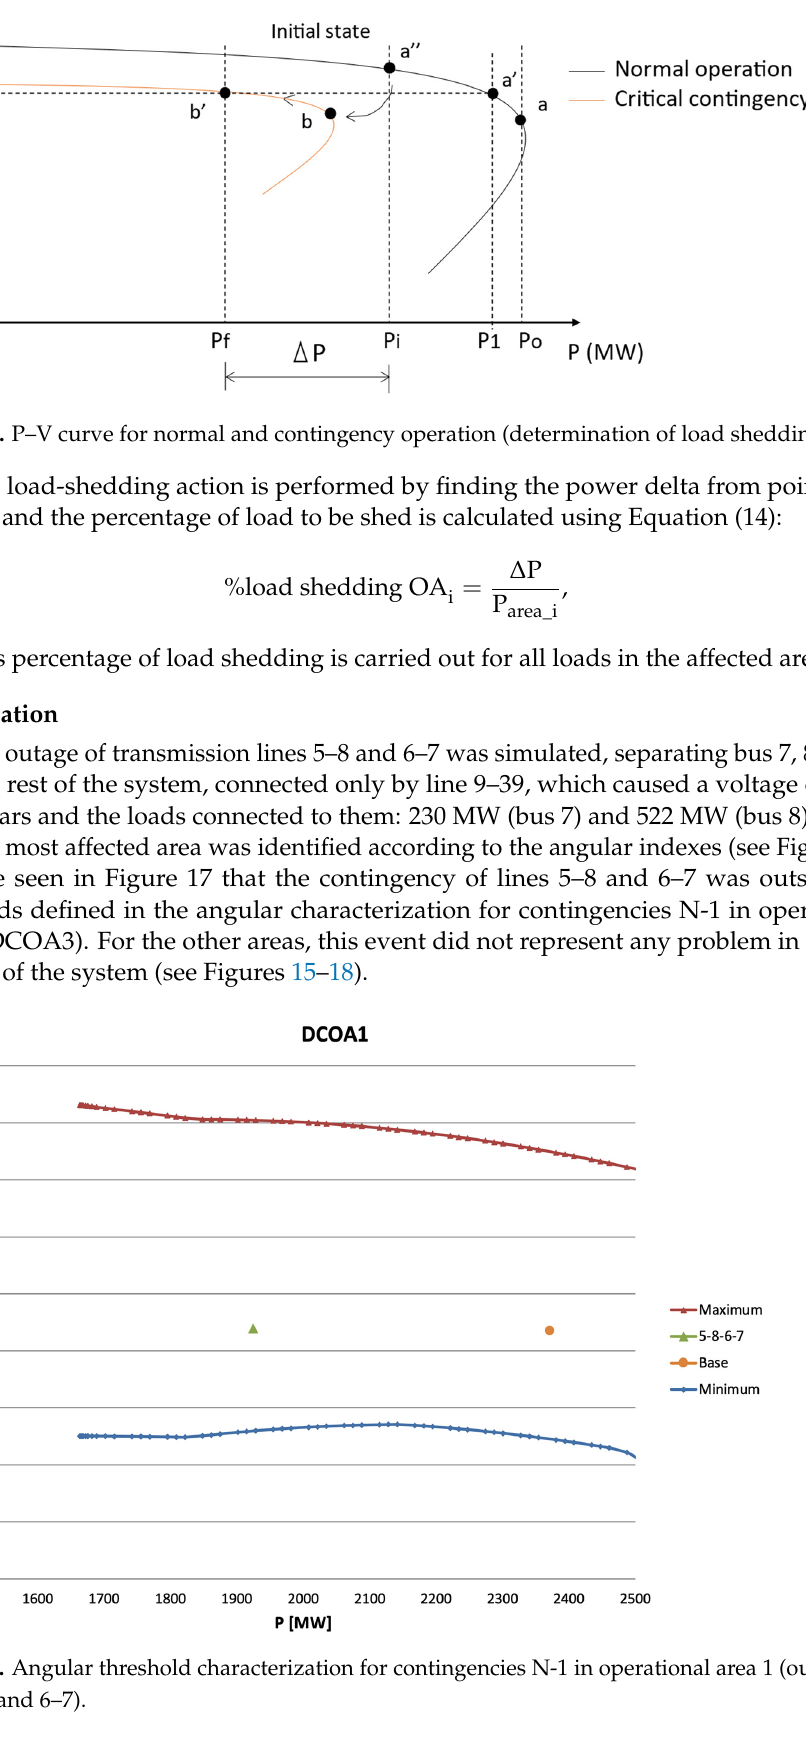
Figure 16. Angular thresholds characterization for contingencies N-1 in operational area 2 (outages of lines 5–8 and 6–7).